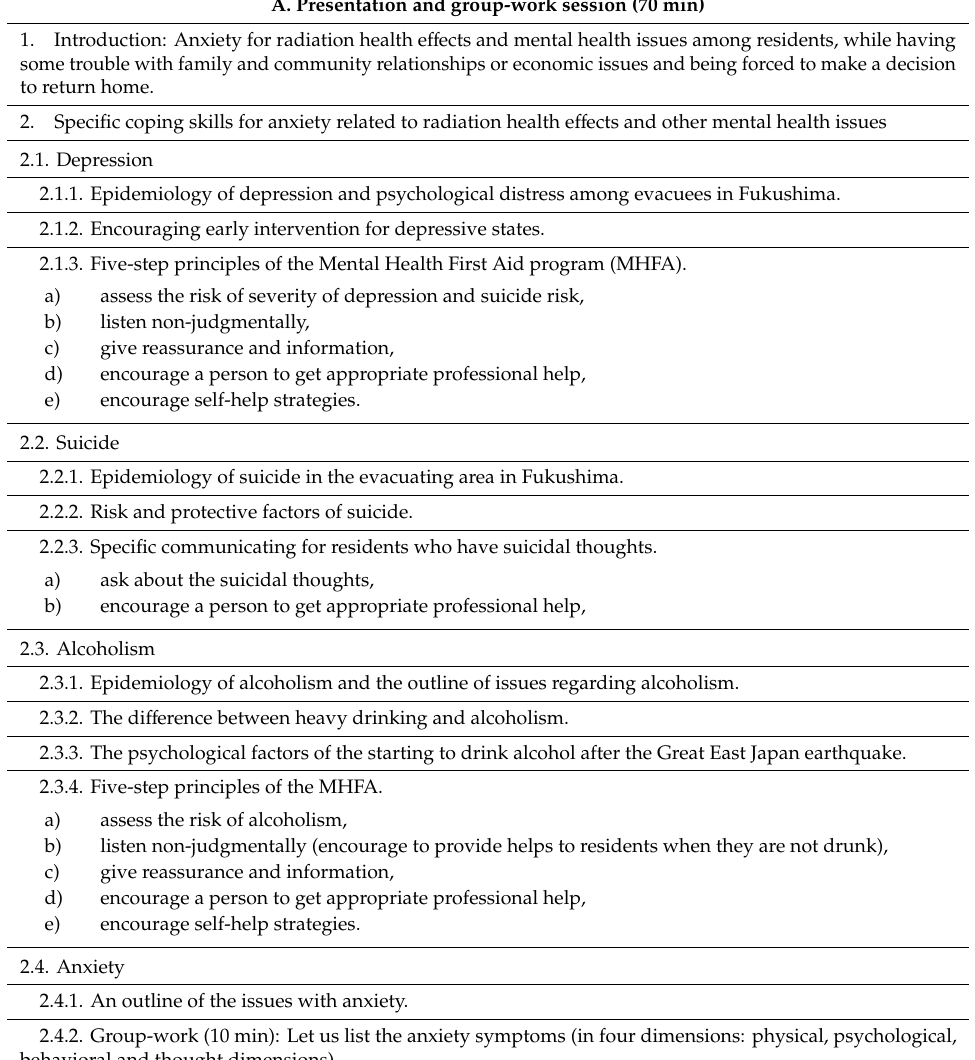
Table 3. Developed gatekeeper training program contents for radiation health anxiety and other mental health